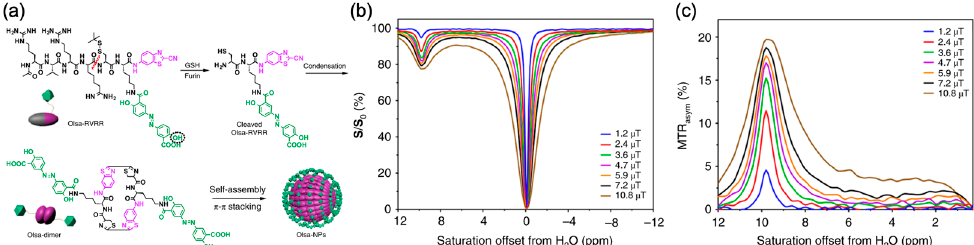
Figure 4. ( a ) Schematic illustration for the formation of Olsa-NPs by furin-mediated intracellular reduction and condensation of Olsa-RVRR; ( b ) Z-spectra and ( c ) MTR asym values of 10 mM olsalazine for different saturation powers. Olsa: olsalazine; NPs: nanoparticles. Reproduced with permission from [157], Springer Nature, 2019.